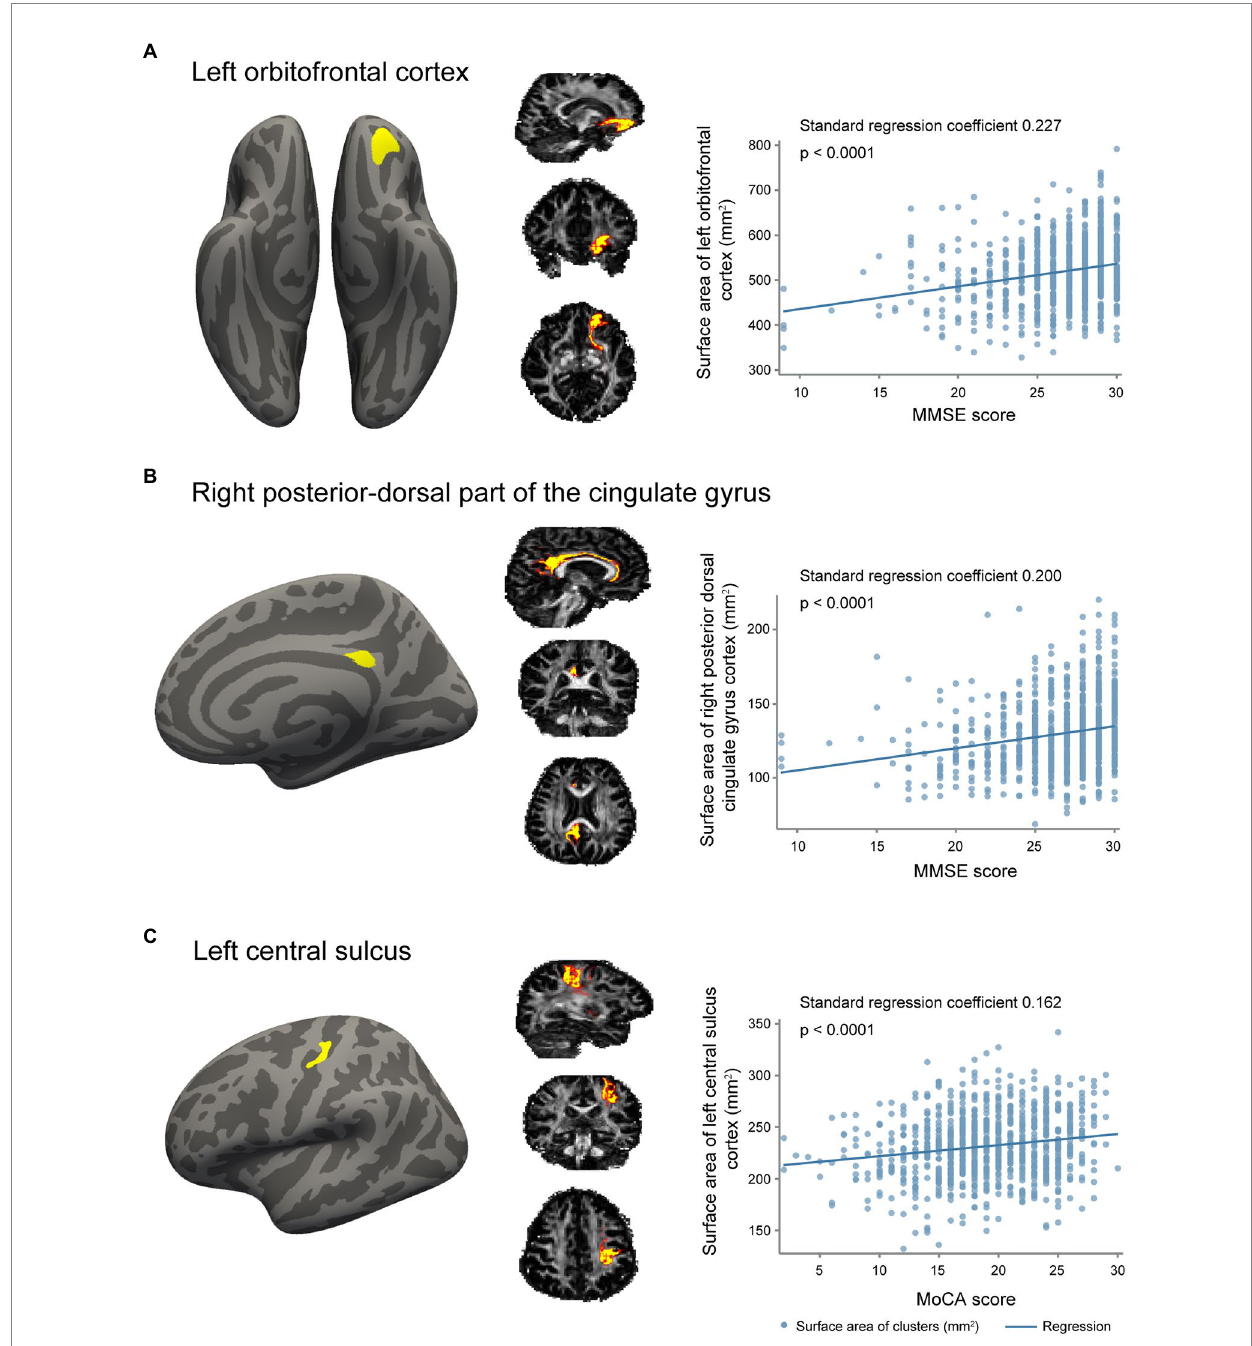
FIGURE 2 Association of gray matter surface area with cognition. (A) The cluster in left orbitofrontal cortex with a surface area positively associated with Mini- Mental State Examination (MMSE) scores, probabilistic tractography of white matter fibers connecting to the cluster, and a scatter plot revealing the association between surface area of this cluster and MMSE scores. (B) The cluster in right posterior-dorsal part of the cingulate gyrus with a surface area positively related with MMSE scores, probabilistic tractography of white matter fibers connecting to the cluster, and a scatter plot revealing the association between surface area of this cluster and MMSE scores. (C) The cluster in left central sulcus with a surface area positively related with Montreal Cognitive Assessment (MoCA) scores, probabilistic tractography of white matter fibers connecting to the cluster, and a scatter plot revealing the association between surface area of this cluster and MoCA